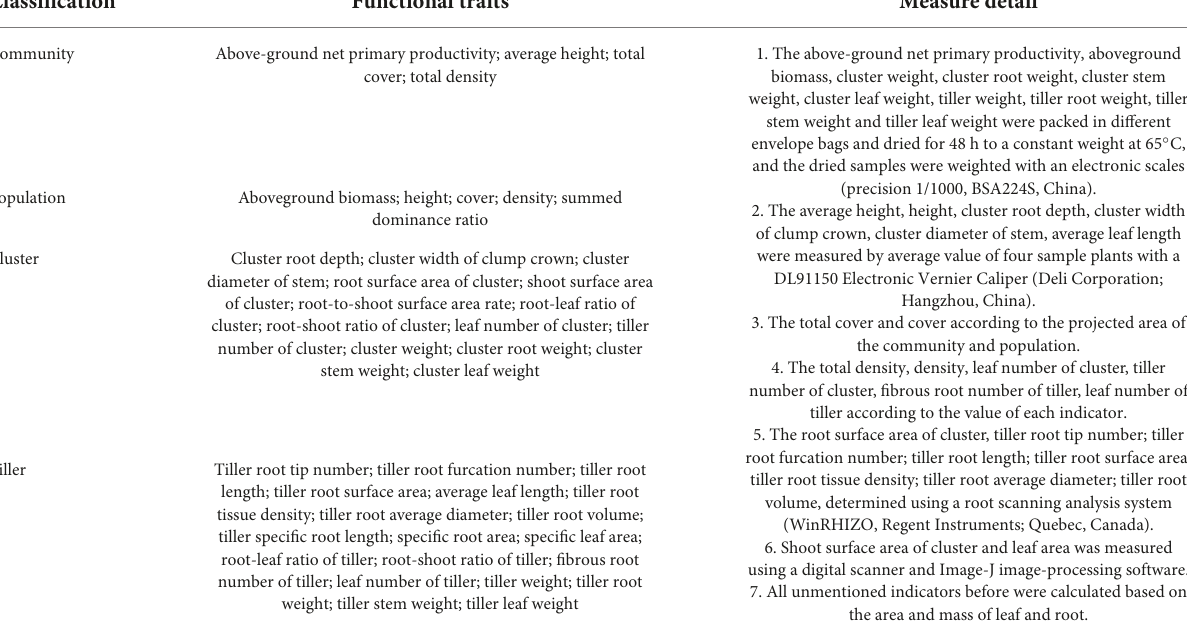
TABLE 1 Plant community characteristics and Stipa breviflora functional traits measured. Classification Functional traits Measure